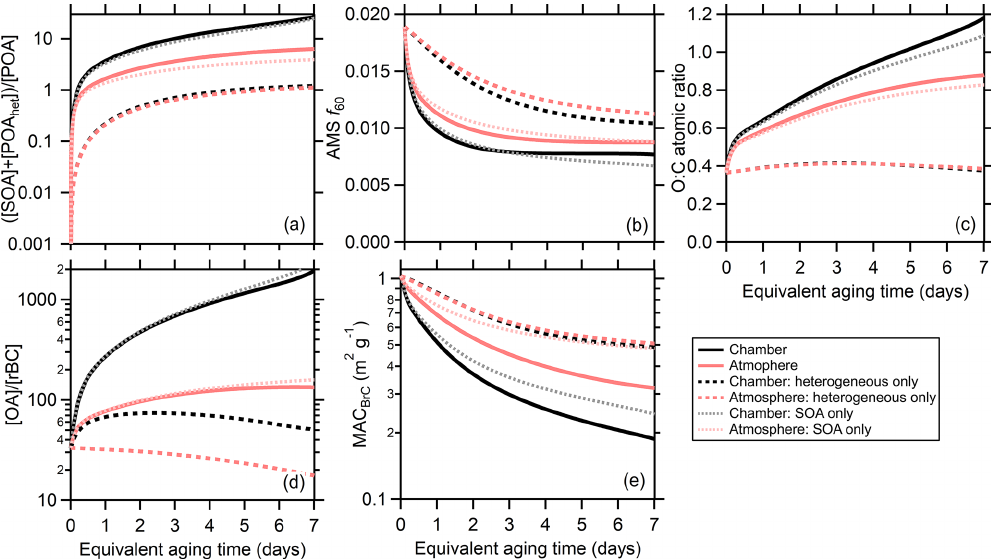
Figure 6. Comparison between the model results when dilution and wall losses are included (the chamber simulation, black lines) or turned off (the atmospheric simulation, red lines). The model has been run with both SOA formation and heterogeneous oxidation (solid lines), with heterogeneous oxidation only (dashed lines), or with SOA formation only (dotted lines). Averages (either arithmetic or geometric) across all particle classes are shown for (a) the SOA-plus-oxidized-POA-to-unoxidized-POA ratio, (b) the AMS f 60 , (c) the organic O:C, (d) the OA-to-rBC ratio, and (e) the MAC BrC , 405